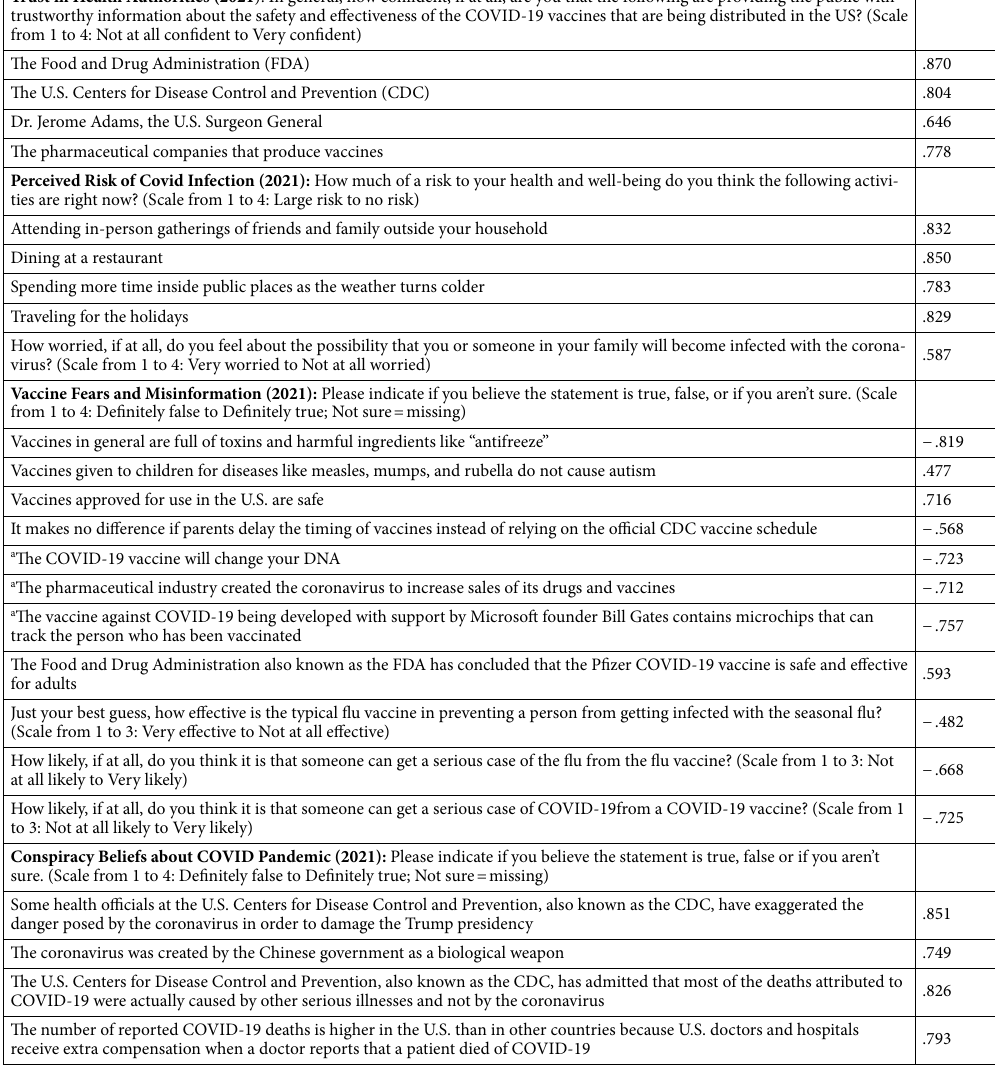
Table 2. Measures used to assess theoretically relevant predictors of vaccination intention in 2021 and standardized loadings on latent factors in measurement model. a These items assessed conspiracies regarding the Covid vaccine but loaded directly on the vaccine misinformation